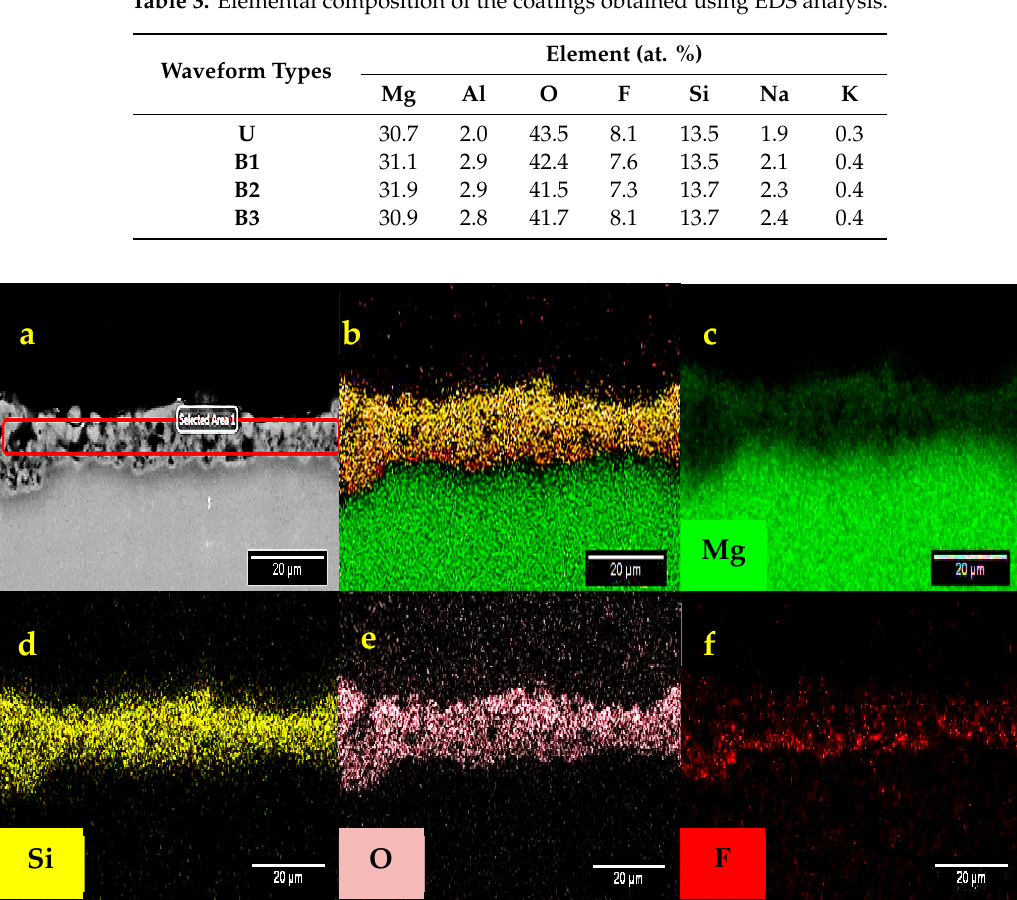
Figure 7. ( a ) Cross-section and elemental maps of B1 produced coating; ( b ) overall colors map, ( c ) map of magnesium, ( d ) map of silicon, ( e ) map of oxygen and ( f ) map of fluoride.